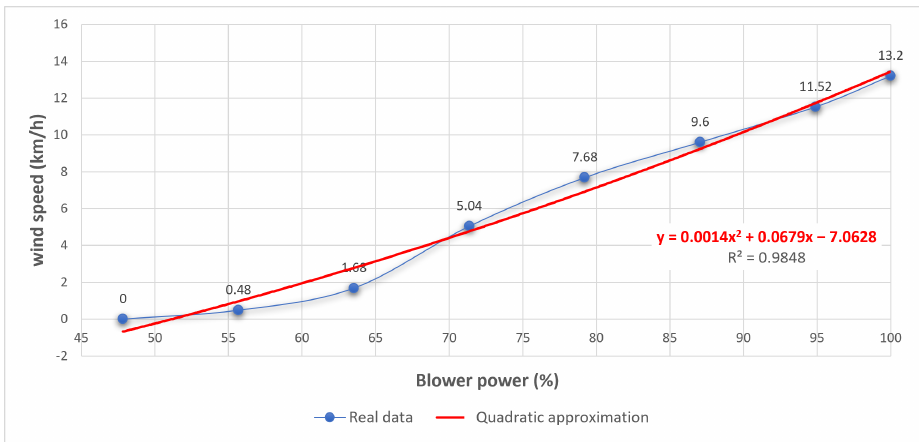
Figure 17. Quadratic regression vs. real